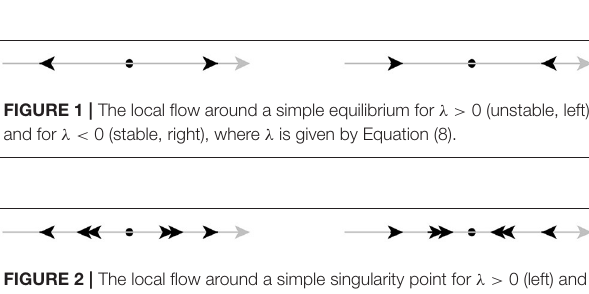
FIGURE 2 | The local flow around a simple singularity point for λ > 0 (left) and for λ < 0 (right), where λ is given by Equation